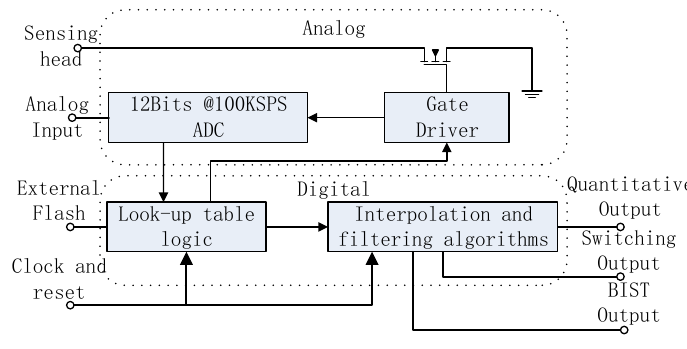
Figure 11. Block diagram of the integrative micro-assembly module.